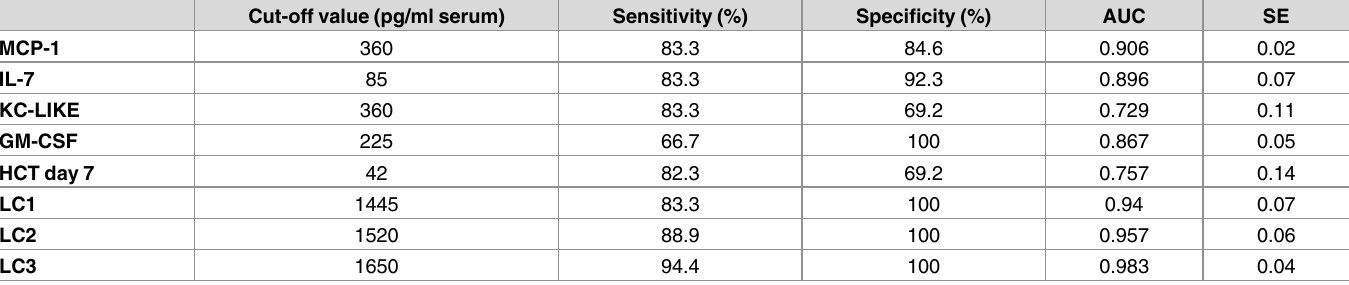
Table 4. Cut-off values (with corresponding True Positive Rate, TPR or sensitivity and False Positive Rate, FPR or 1-specificity) and AUC for cyto- kines and hematologic parameters. All values correspond to day 1 except HCT. Curve Sensitivity and specificity are indicatedfor each cut-off value. AUC: Area Under the Curve, SE: Standard